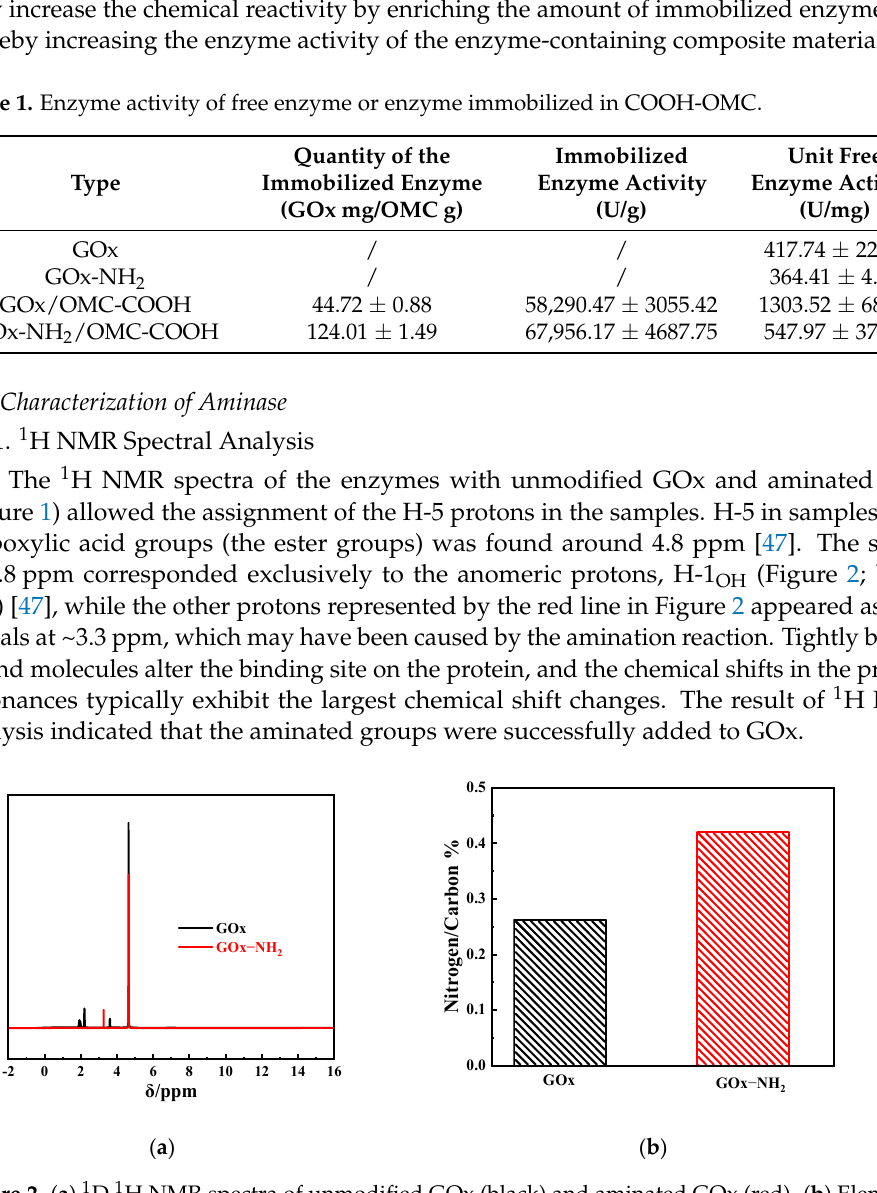
Figure 2. ( a ) 1 D 1 H NMR spectra of unmodified GOx (black) and aminated GOx (red). ( b ) Elemental analysis results of GOx (black) and aminated GOx (red).